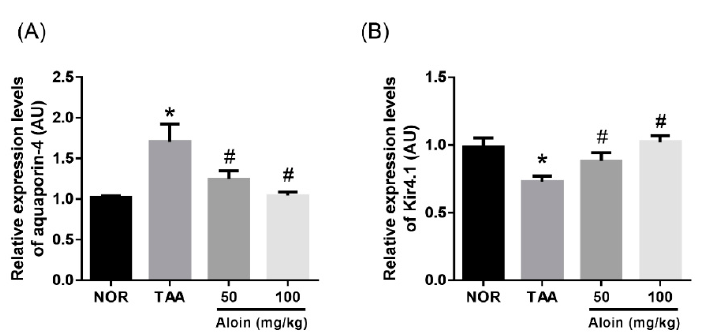
Figure 6. Effect of aloin on aquaporin-4 and Kir4.1 mRNA expression. Real-time PCR analysis of ( A ) aquaporin-4 and ( B ) Kir4.1 mRNA levels. The data are shown as the mean ± SEM, n = 7, * p < 0.05 vs. normal control rats, # p < 0.05 vs. TAA-injected rats.